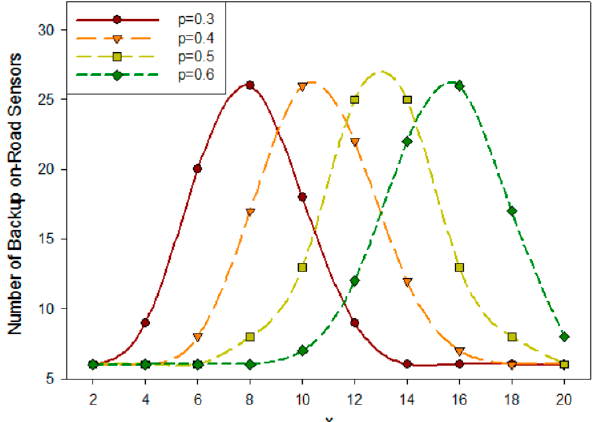
Figure 4. The relation among number of backup sensors, failure rate and x .